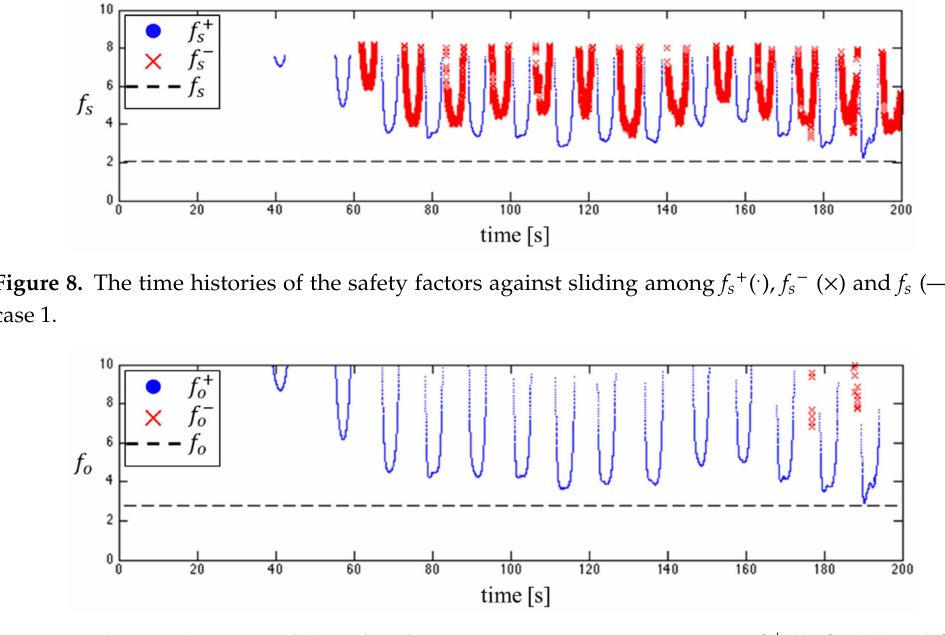
Figure 9. The time histories of the safety factors against overturning among f o + ( . ), f o − ( × ) and f o (—) for case